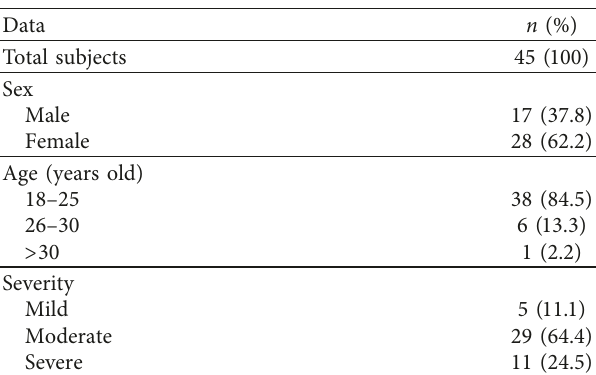
Table 1: Demograhic